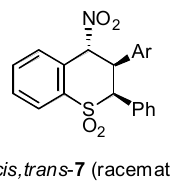
Figure 3. Main diastereoisomer isolated from the preparation of 7 (see Scheme 2).